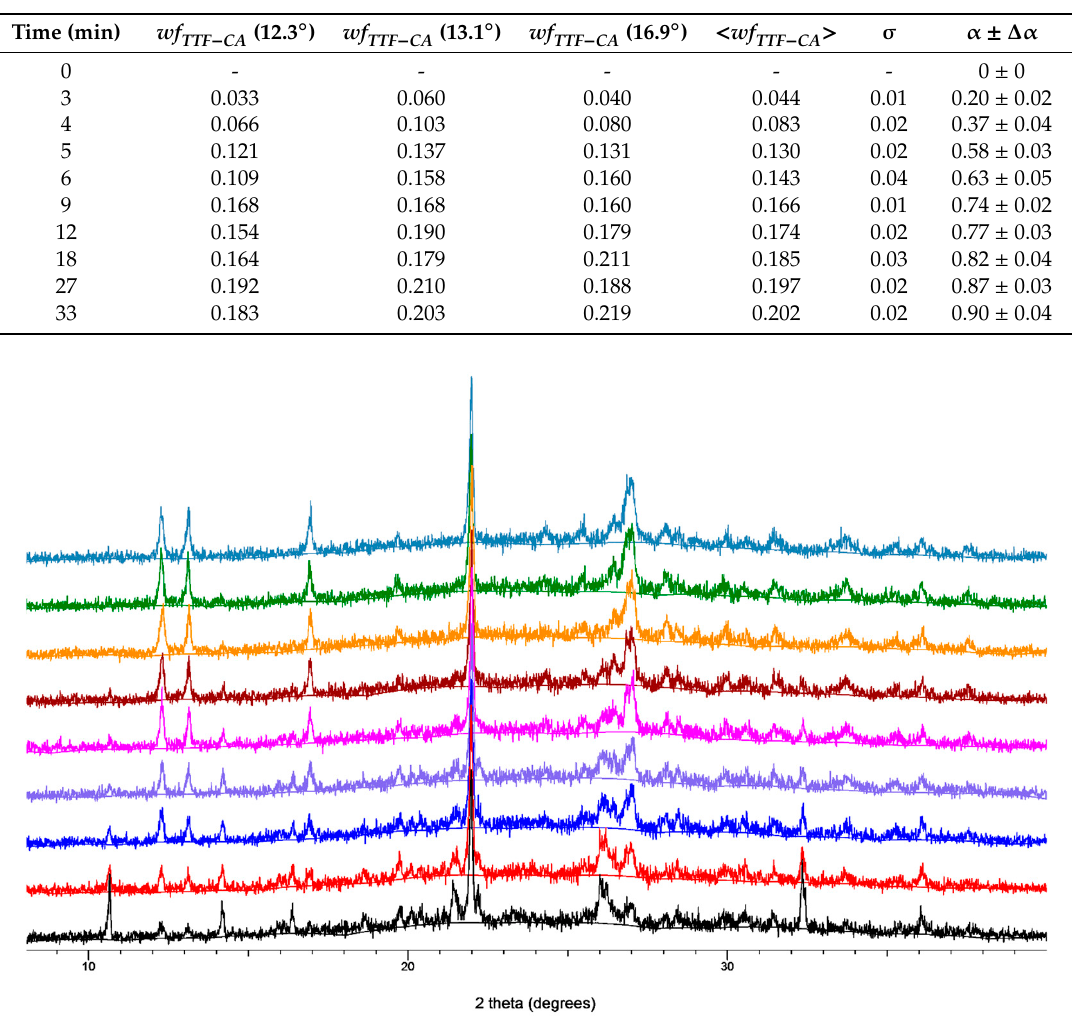
Table 1. Reaction times; TTF-CA weight fractions ( 𝑤𝑓 (cid:3021)(cid:3021)(cid:3007)(cid:2879)(cid:3004)(cid:3002) ) averaged from three consecutive XRPD scans using the calibration curves based in the diffraction peaks at 12.3 ° , 13.1 ° and 16.9 °, respectively; the average of the nine 𝑤𝑓 (cid:3021)(cid:3021)(cid:3007)(cid:2879)(cid:3004)(cid:3002) values (< 𝑤𝑓 (cid:3021)(cid:3021)(cid:3007)(cid:2879)(cid:3004)(cid:3002) >); its standard deviation ( σ ); the calculated α , and an estimated uncertainty, Δ𝛼 = 𝛼 ×